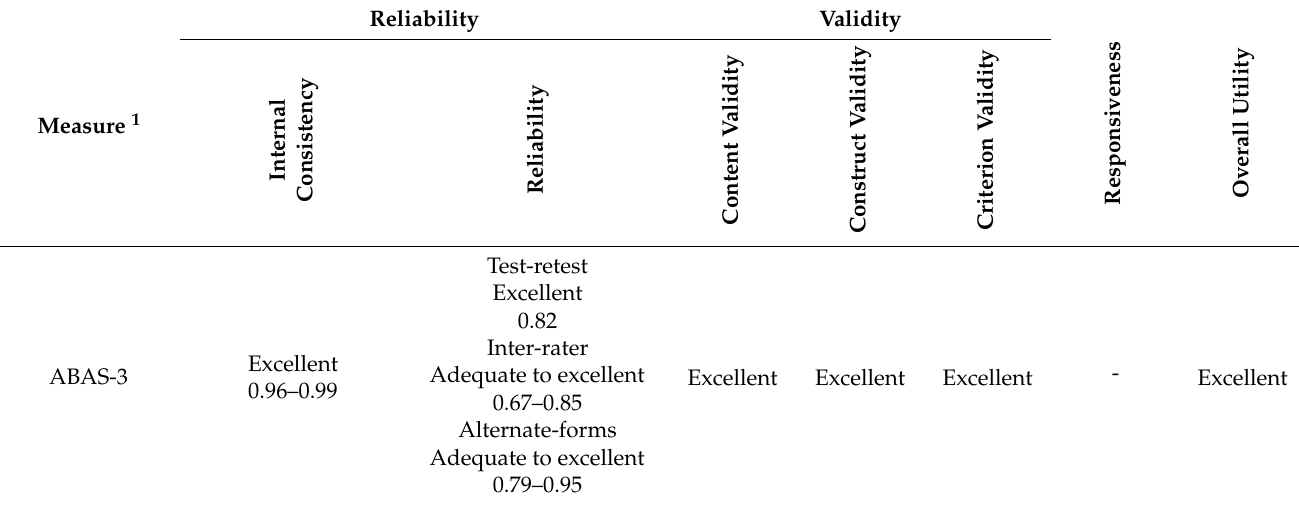
Table 4. Characteristics of included assessment of functioning